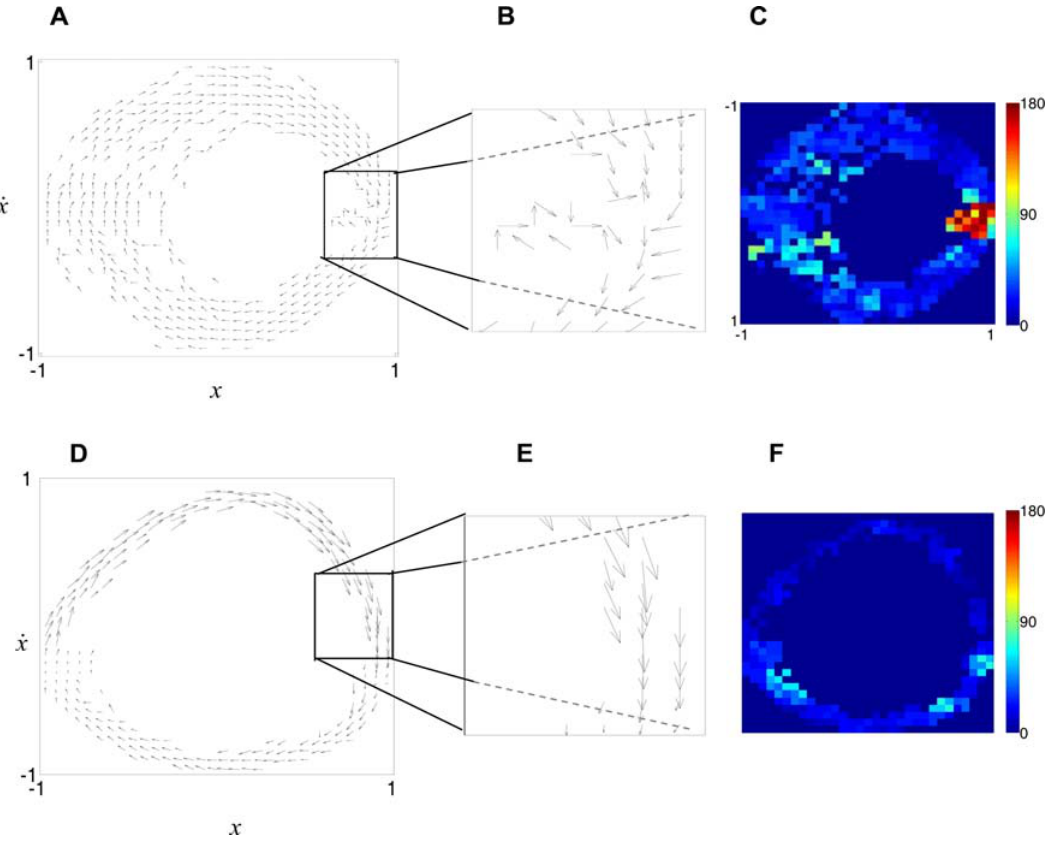
Figure 3. Reconstructed vector field and corresponding angles between neighbouring phase flow vectors corresponding to five trials from one participant. Horizontal axes represent normalized position ( x ); vertical axes represent normalized velocity ( _ xx ) (only indicated in [A] and [D]). (A) Reconstructed vector field for the discrete condition at 0.5 Hz (left; see text and Data Analysis). (B) Enlarged representation of the boxed area in (B). (C) Corresponding angle diagram. While the existence of a fixed point (vectors with different directions pointing towards a point [i.e., the arrowheads converge]) and a separatrix (that locally divides the space in distinct flows; vectors with different directions pointing away from a point [i.e., the arrowheads diverge]) can be directly glanced from (B), they have to be inferred from (C). The existence of locally opposing angles, however, necessarily implies the presence of a fixed point and a separatrix. (D–F) Equivalent representations as in (A–C) corresponding to five trials from one participant in the ‘discrete’ condition at 3.5 Hz. Vectors inside and outside the limit cycle point slightly towards it while being close to parallel to